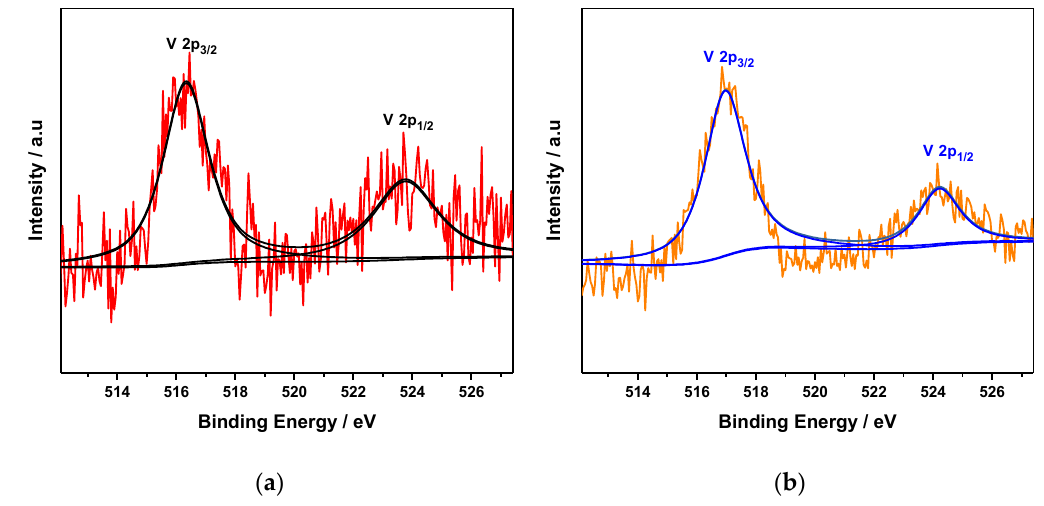
( a ) ( b ) Figure 7. XPS spectra of V 2p of UiO-67-KVO(O 2 ) 2 before ( a ) and after ( b ) reactions. Table 3. Comparison of cyclohexane oxidation in MeCN solution by various vanadium based catalysts. Selectivity Catalyst Time/h Temp./ o C Conv. a /% Refs CyOH Cyone KA oil CHHP Others UiO-67-KVO(O 2 ) 2 VPO VPO-Co(0.10)